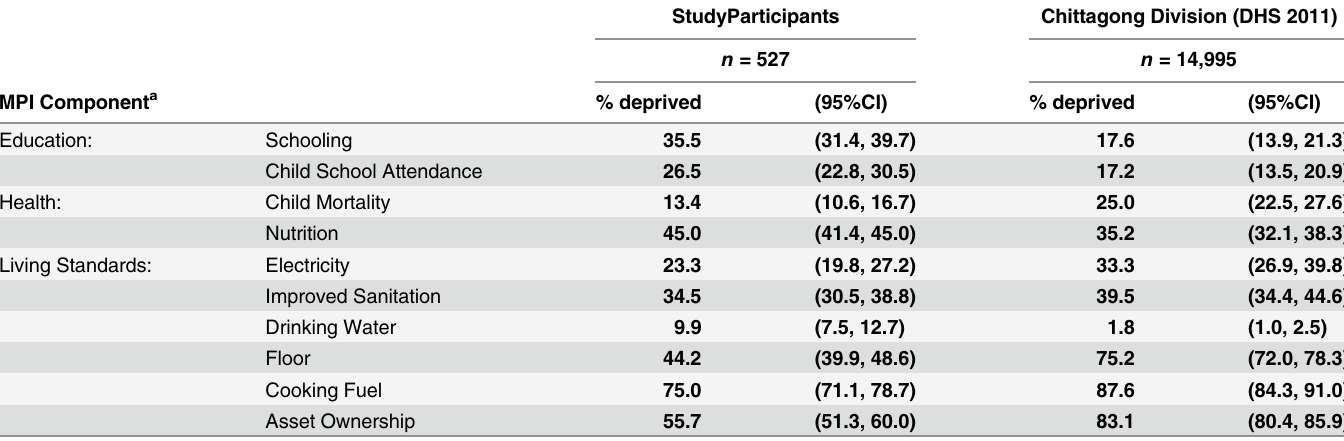
Table 2. Prevalence of MPI components as % of the population, among study participants compared to the DHS 2011 Survey of Chittagong